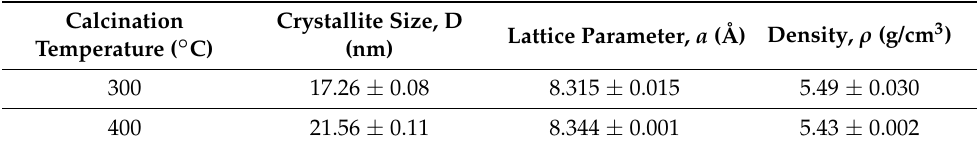
Table 2. Crystallite size, lattice parameter and density of nanoparticles Sr-CoFe 2 O 4 at difference calcination temperature.